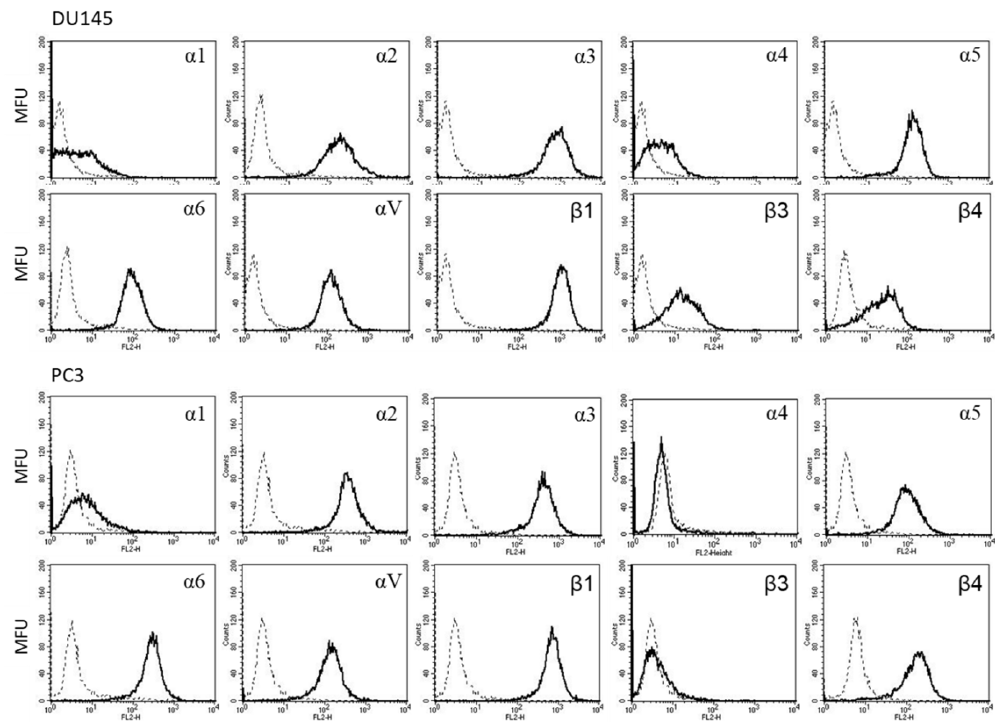
Figure 7. Surface expression of integrin α and β subtypes on DU145 and PC3 cells. Counts indicate mean fluorescence units (MFU). One representative of three separate experiments is shown. Solid line: specific fluorescence; dashed line: isotype control.